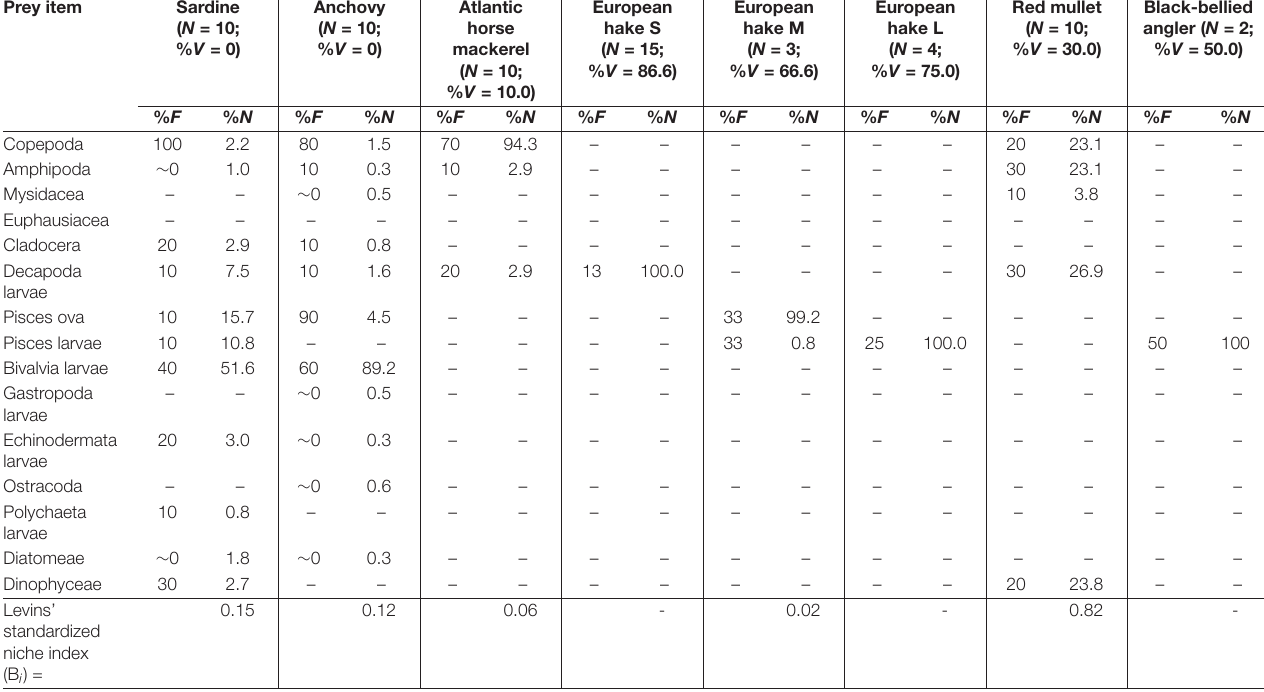
TABLE 2 | Frequency of occurrence (% F ) and abundance (% N ) of prey items found in the sardine, anchovy, Atlantic horse mackerel, European hake [by size classes: small (S: TL < 20.0 cm), medium (M: 20.1 cm < TL < 30.0 cm) and large (L: 30.1 cm > TL)], red mullet and black-bellied angler collected in the Middle area of eastern Adriatic Sea during MEDITS survey (June–July, 2018) along with number of analyzed specimens ( N ), its vacuity index (% V ) and Levins’ standardized index (B i ). Prey item Sardine ( N =